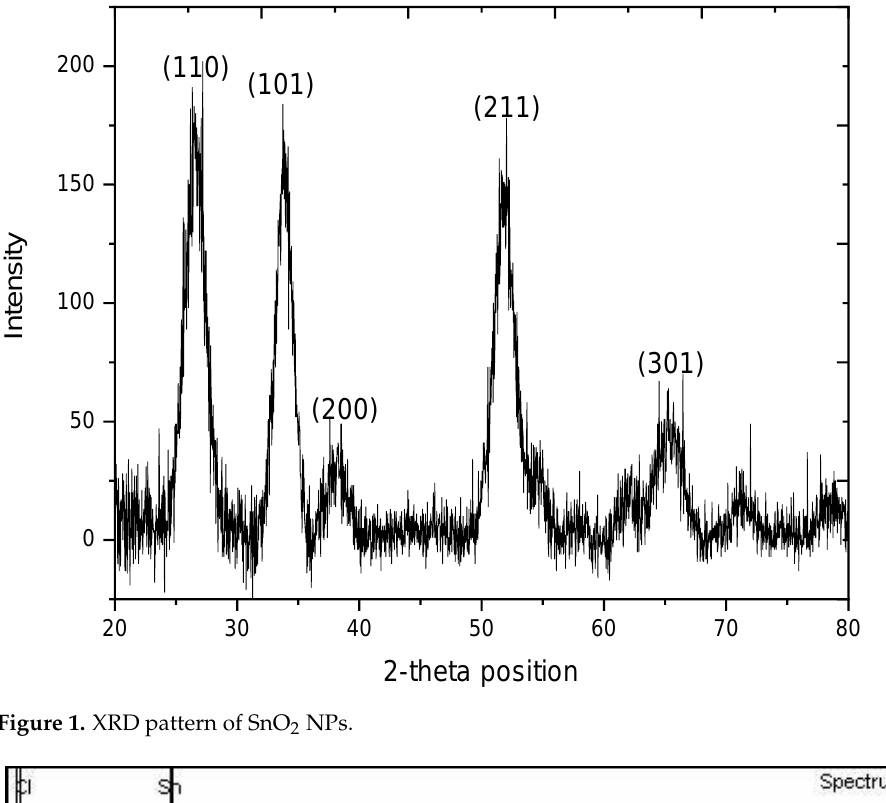
Figure 1. XRD pattern of SnO 2 NPs.